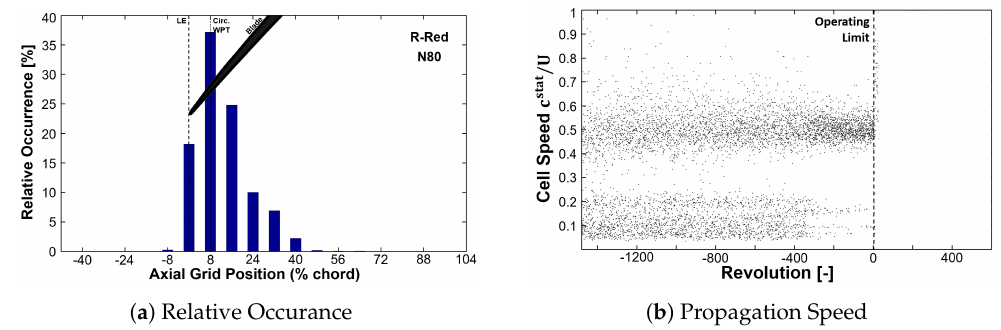
Figure 10. Characterization of Aerodynamic Disturbances for R-Ref at Part Speed